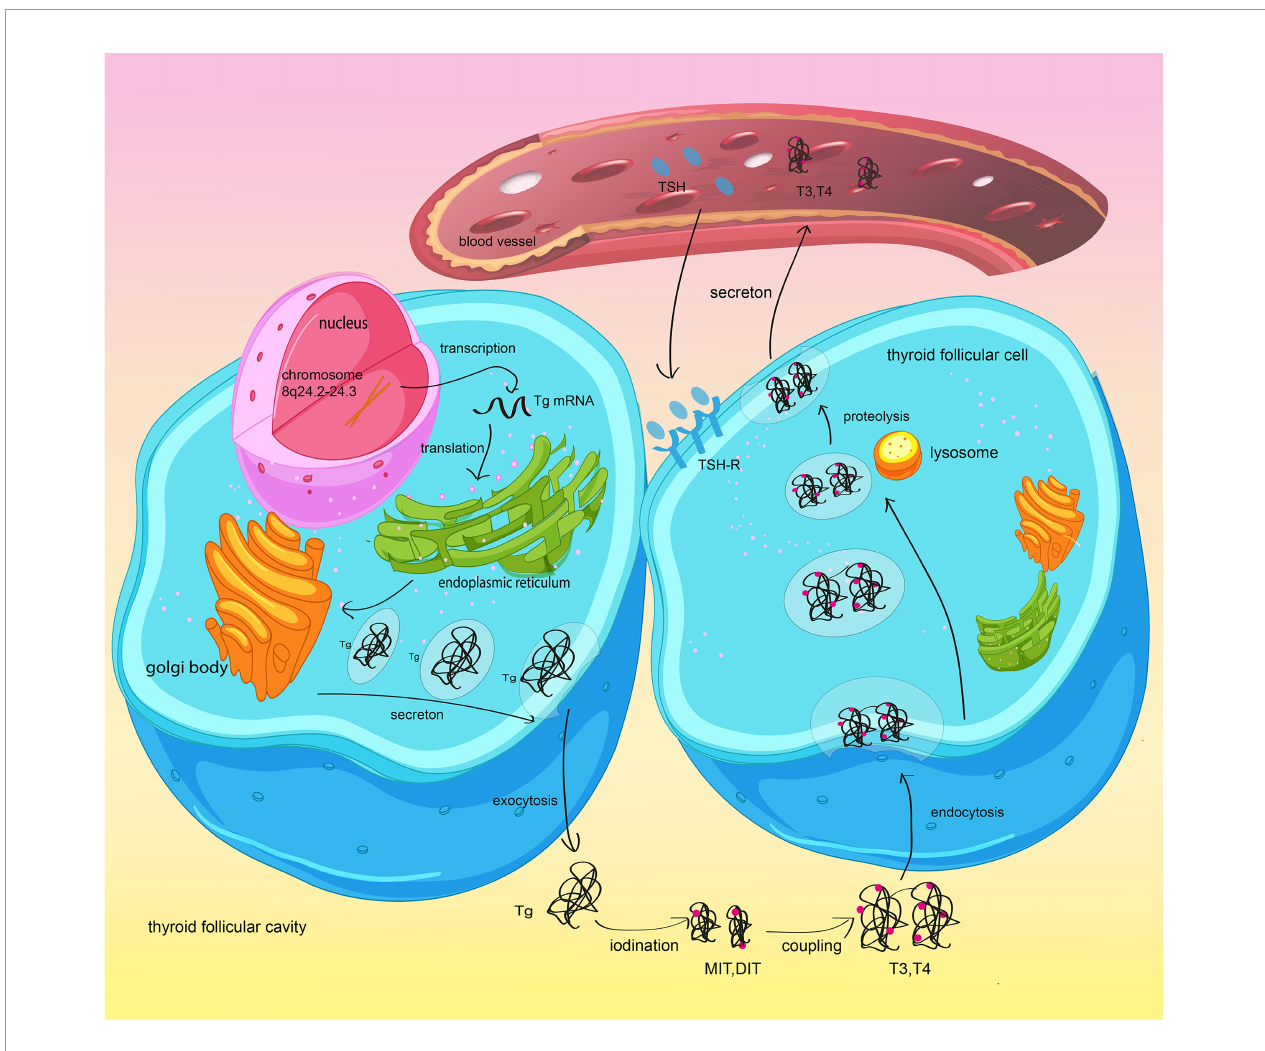
FIGURE 1 | Synthesis and secretion of thyroglobulin and thyroid hormones. Thyroid follicular cells synthetize Tg and secrete it into the thyroid follicular lumen by exocytosis. Reactive iodide is covalently linked to speci fi c tyrosyl residues of thyroglobulin (Tg) and generate MIT and/or DIT. MIT/DIT form T3 and T4 through coupling. When TSH combines with TSH-R in thyroid follicular cells, the newly synthesized thyroid hormone will be increasingly transported to the